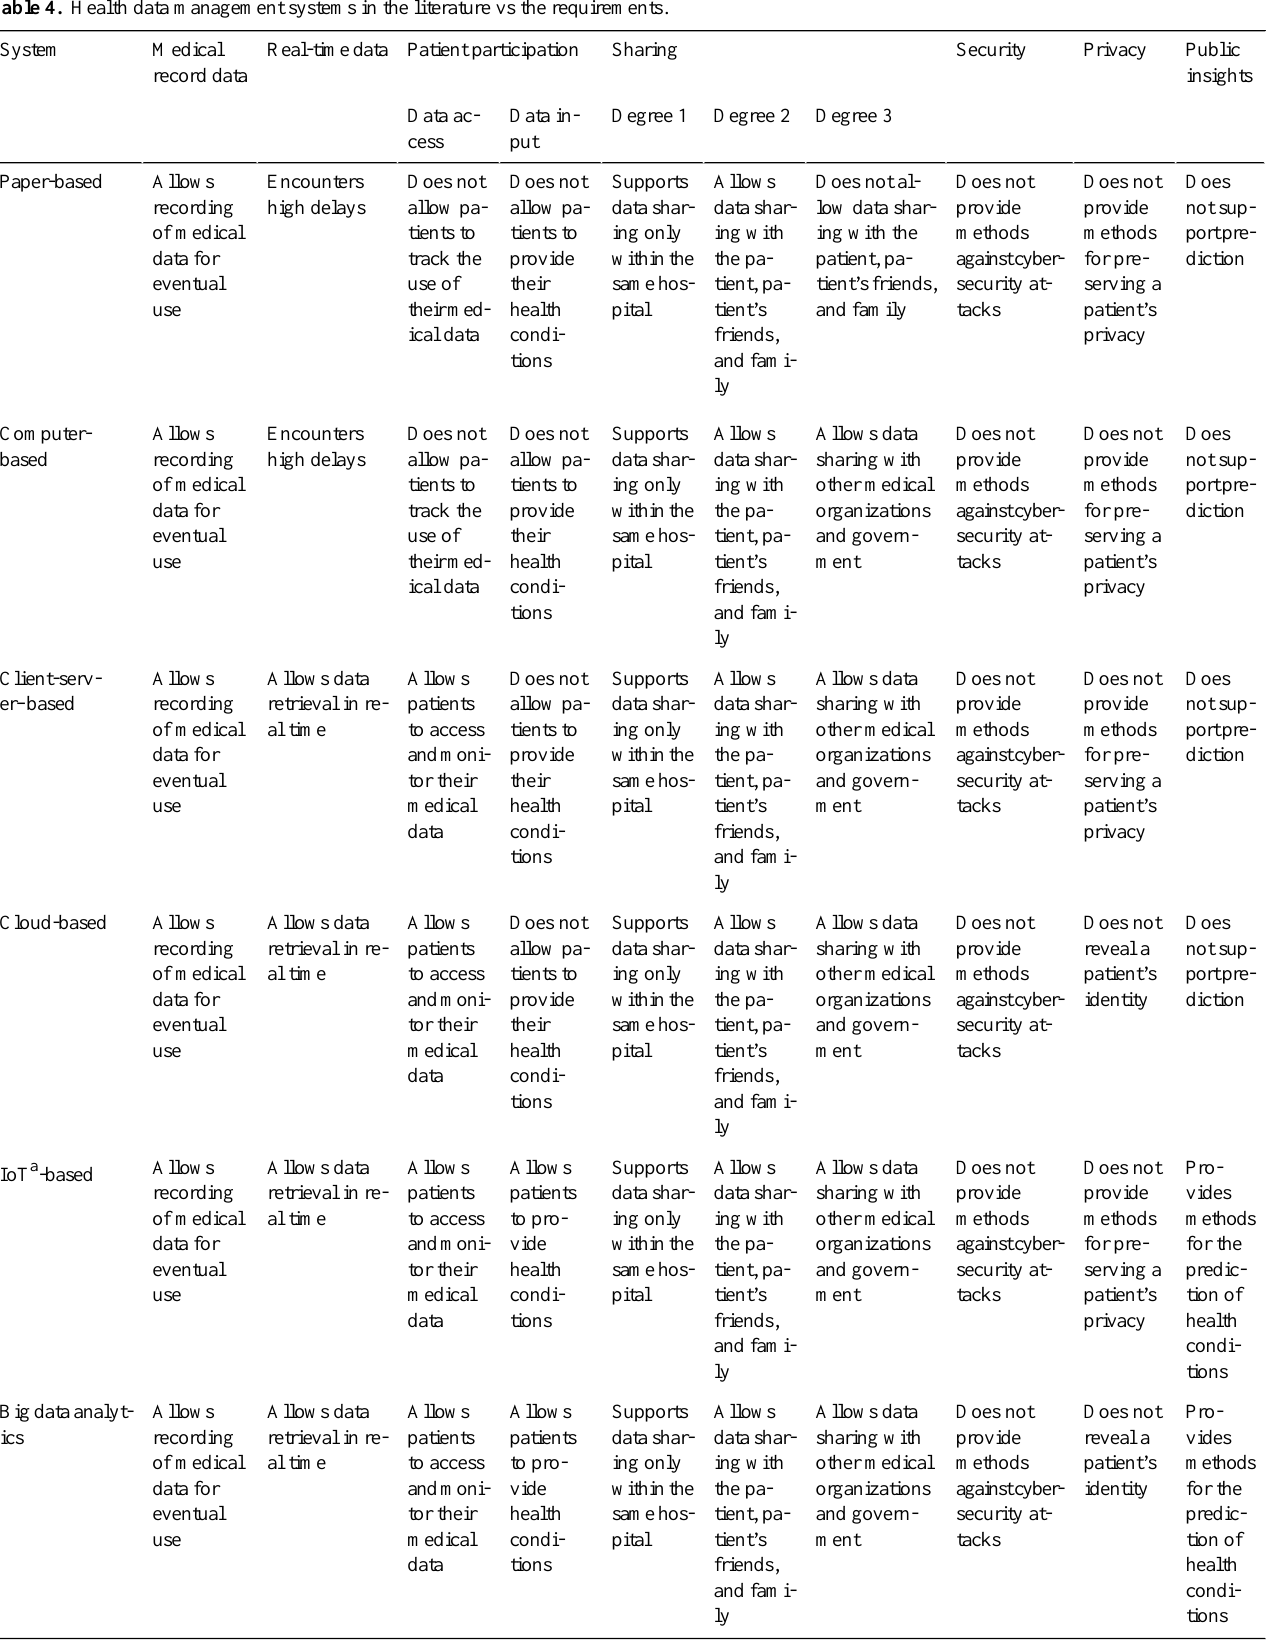
Table 4. Health data management systems in the literature vs the